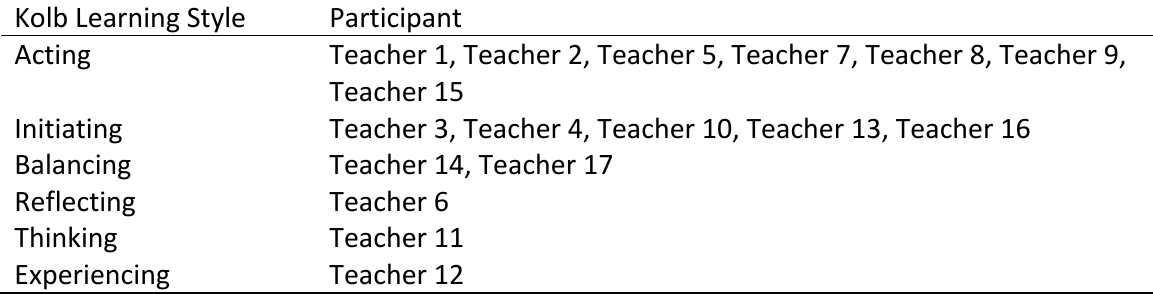
Summary of Participants’ Individual Kolb LSI Learning